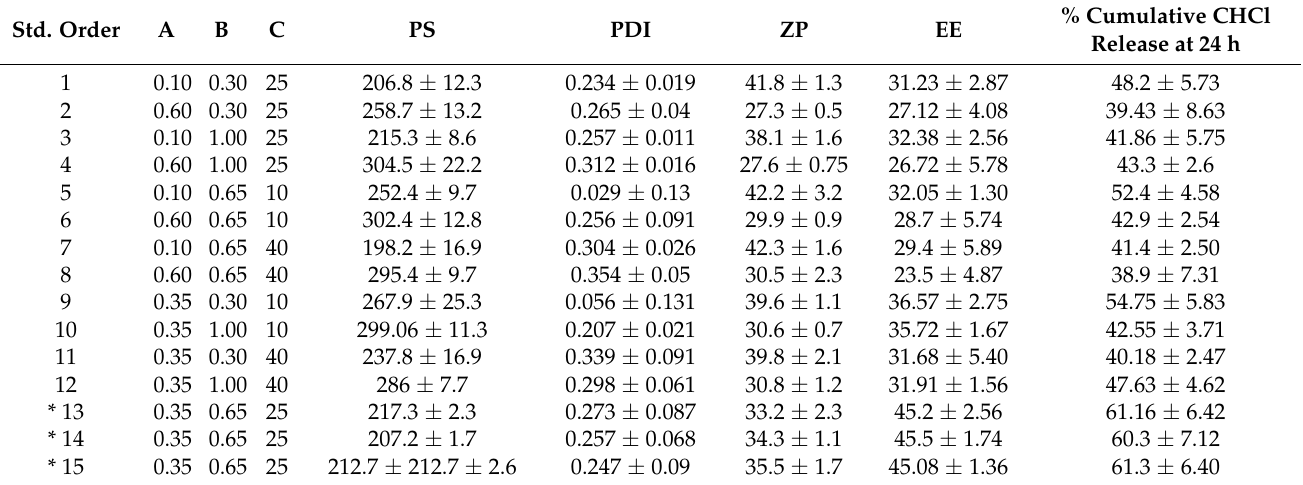
Table 5. Box–Behnken experimental design showing independent variables with measured responses (* center